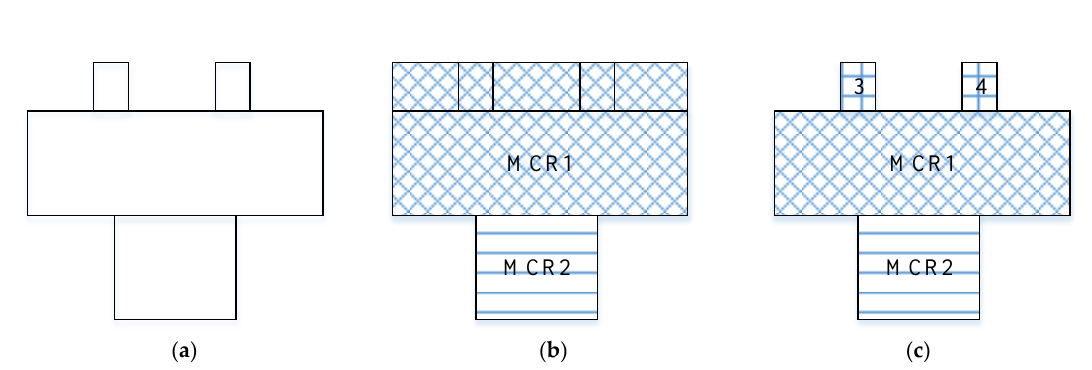
Figure 6. Example of MCR detection. ( a ) Ground plan. ( b ) Main MCR. ( c ) All detected MCRs Prototype Extraction and Classification